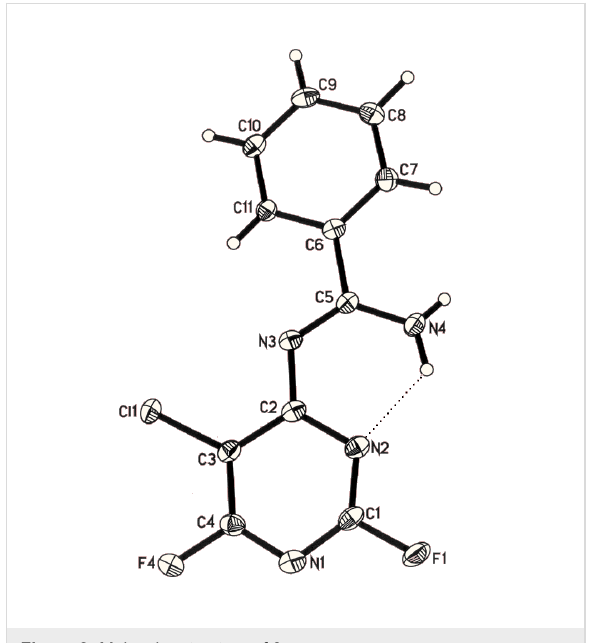
Figure 2: Molecular structure of 3g